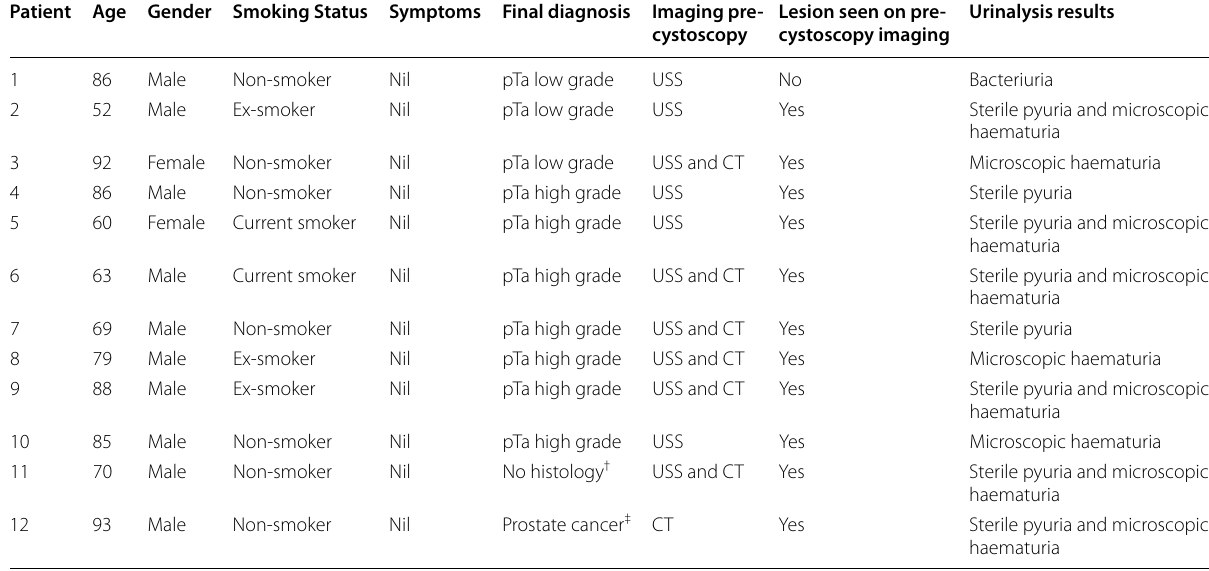
† Patient died prior to bladder lesion resection ‡ Patient has a PSA of 77, a malignant digital rectal exam and a normal cystoscopy. Hence, a clinical diagnosis of prostate cancer was established